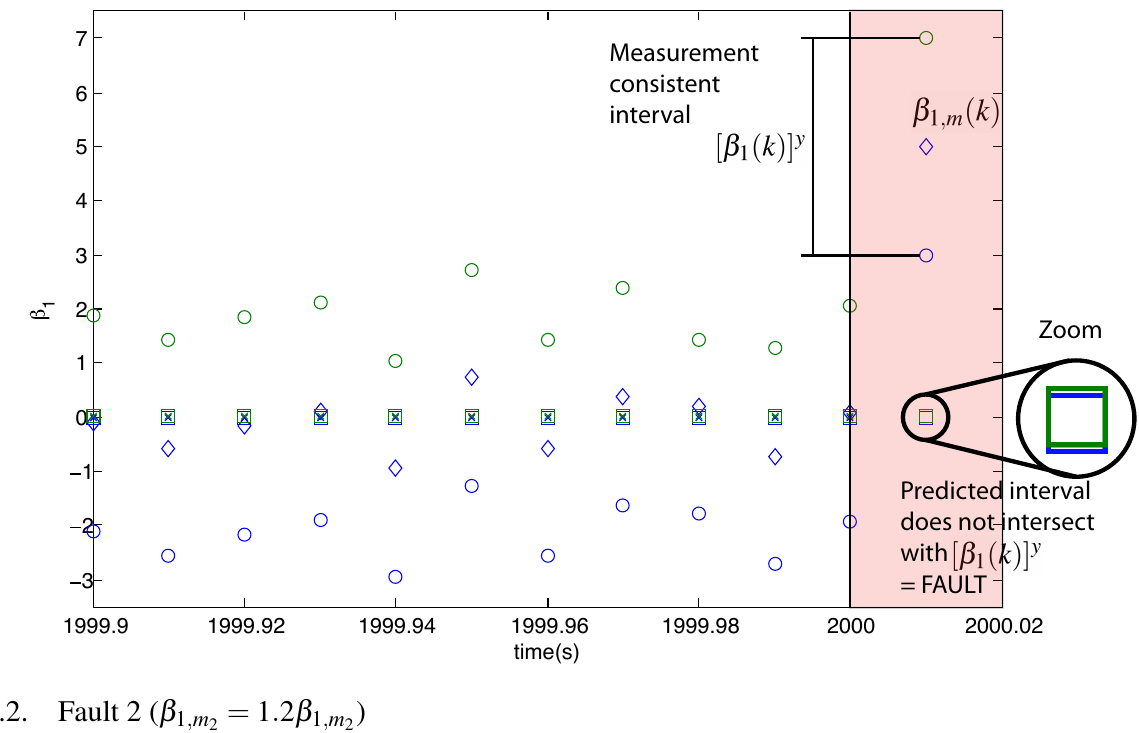
( k ) , ◦ : [ β ( k )] y , (cid:3) : [ β ( k )] p 1 , m 1 1